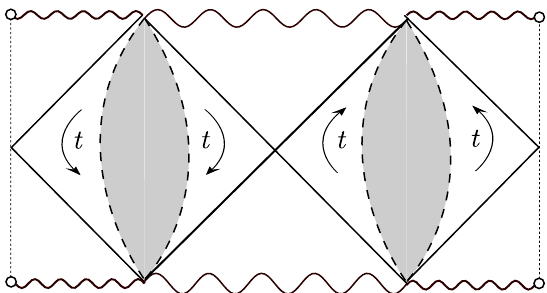
Figure 8. The Penrose diagram for two eternal black holes with different inverse temperatures β 1 , β 2 connected by two copies of the reservoir (shown by the shaded regions) with the conical metric (3.4). The arrows show the direction of the coordinate time in the external regions of the black holes. The diagram is identified across the dashed line which goes through the bifurcation surface of the second black